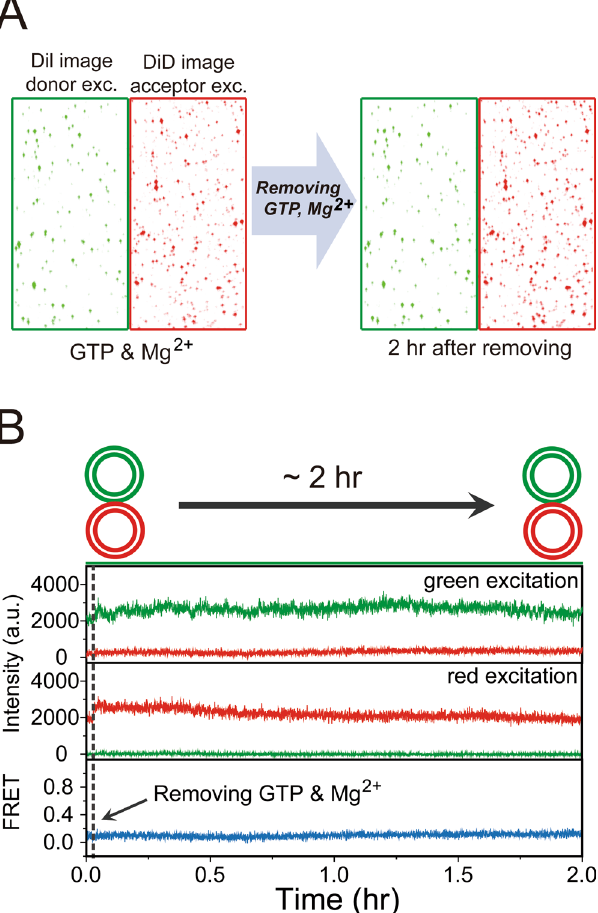
Figure 3. Multiple GTPase cycles are not required to maintain membrane tethering. ( A ) Single-vesicle images upon donor and acceptor excitation before and after removing GTP and Mg 2 + . Three independent experiments all indicated that the tethered vesicles did not dissociate. ( B ) Representative time traces observed in a buffer- exchange experiment. Buffer lacking GTP and Mg 2 + was injected into the detection chamber during incubation of donor vesicles in the presence of GTP and Mg 2 + . Experiments were performed using proteoliposomes with a protein-to-lipid ratio of